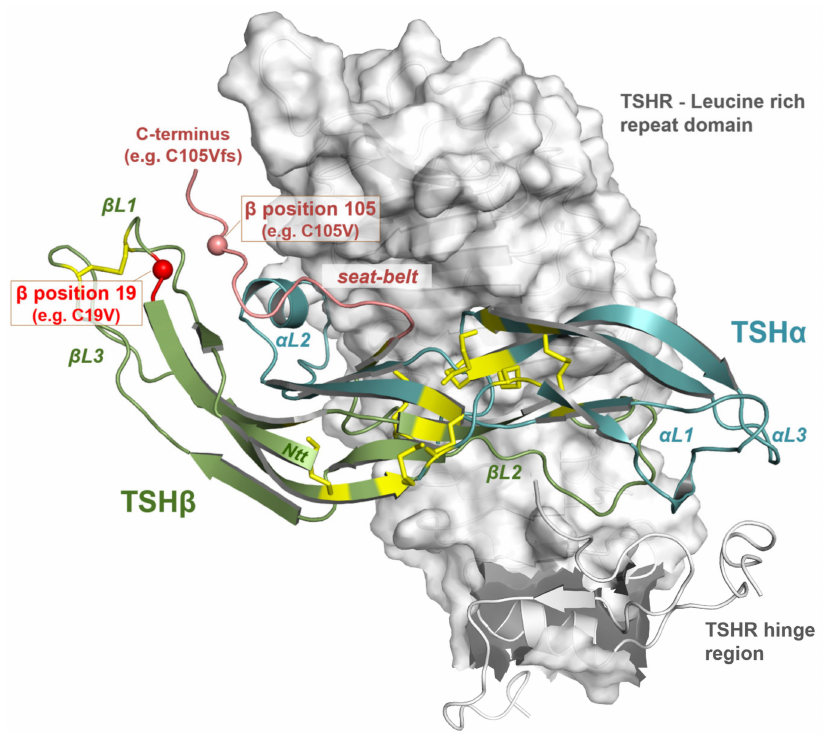
Figure 3. Homology model of bound TSH at extracellular TSHR components. This TSHR (partial, translucent surface representation of the LRRD)–TSH complex model was designed, as previously described [36], based on the solved X-ray structure of the follitropin receptor (FSHR) ectodomain with bound FSH (follicle-stimulating hormone) [37]. The orientation of TSH (WT) at the receptor is likely similar as observed for the homologous FSH at the FSHR. While we cannot predict how the TSH mutants in this study bind to the ectodomain, this model highlights respective features involved in the ligand binding and where the (pathogenic) modifications are spatially located in the hormone structure and in the formed putative complex. Details of the heterodimeric hormone structure are labeled, e.g., the loop regions of each subunit (alpha and beta) or the “seat-belt” region which are most likely justified by the WT disulfide-bridge between cysteins C19 and C105. The constructs tested in this current study are modified at these positions (Figure 3) and at the Ctt of the beta-subunit as observed in the patient mutant. Therefore, it must be assumed that the receptor / hormone complex can be di ff erent in detail comparing WT and modified TSH. TSH disulfide-bridges are represented as yellow sticks. For structure presentation and image production the PyMOL software was used (Molecular Graphics System, version 1.5; Schrödinger,